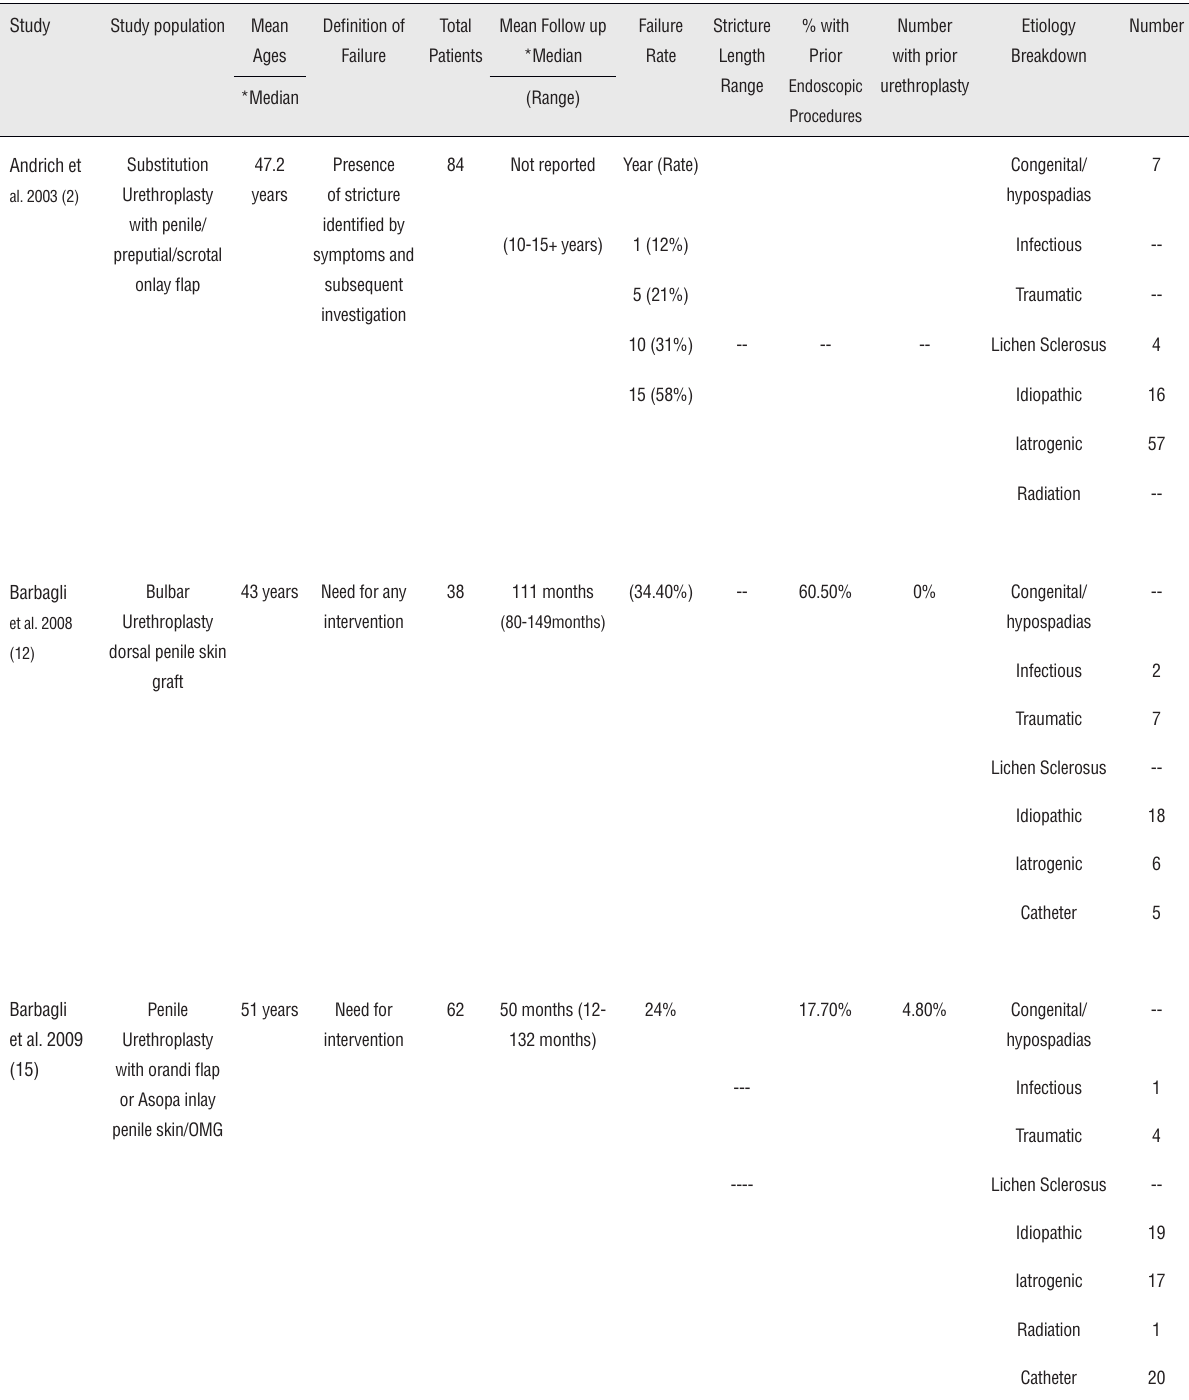
population, age, definition of failure, follow-up, and